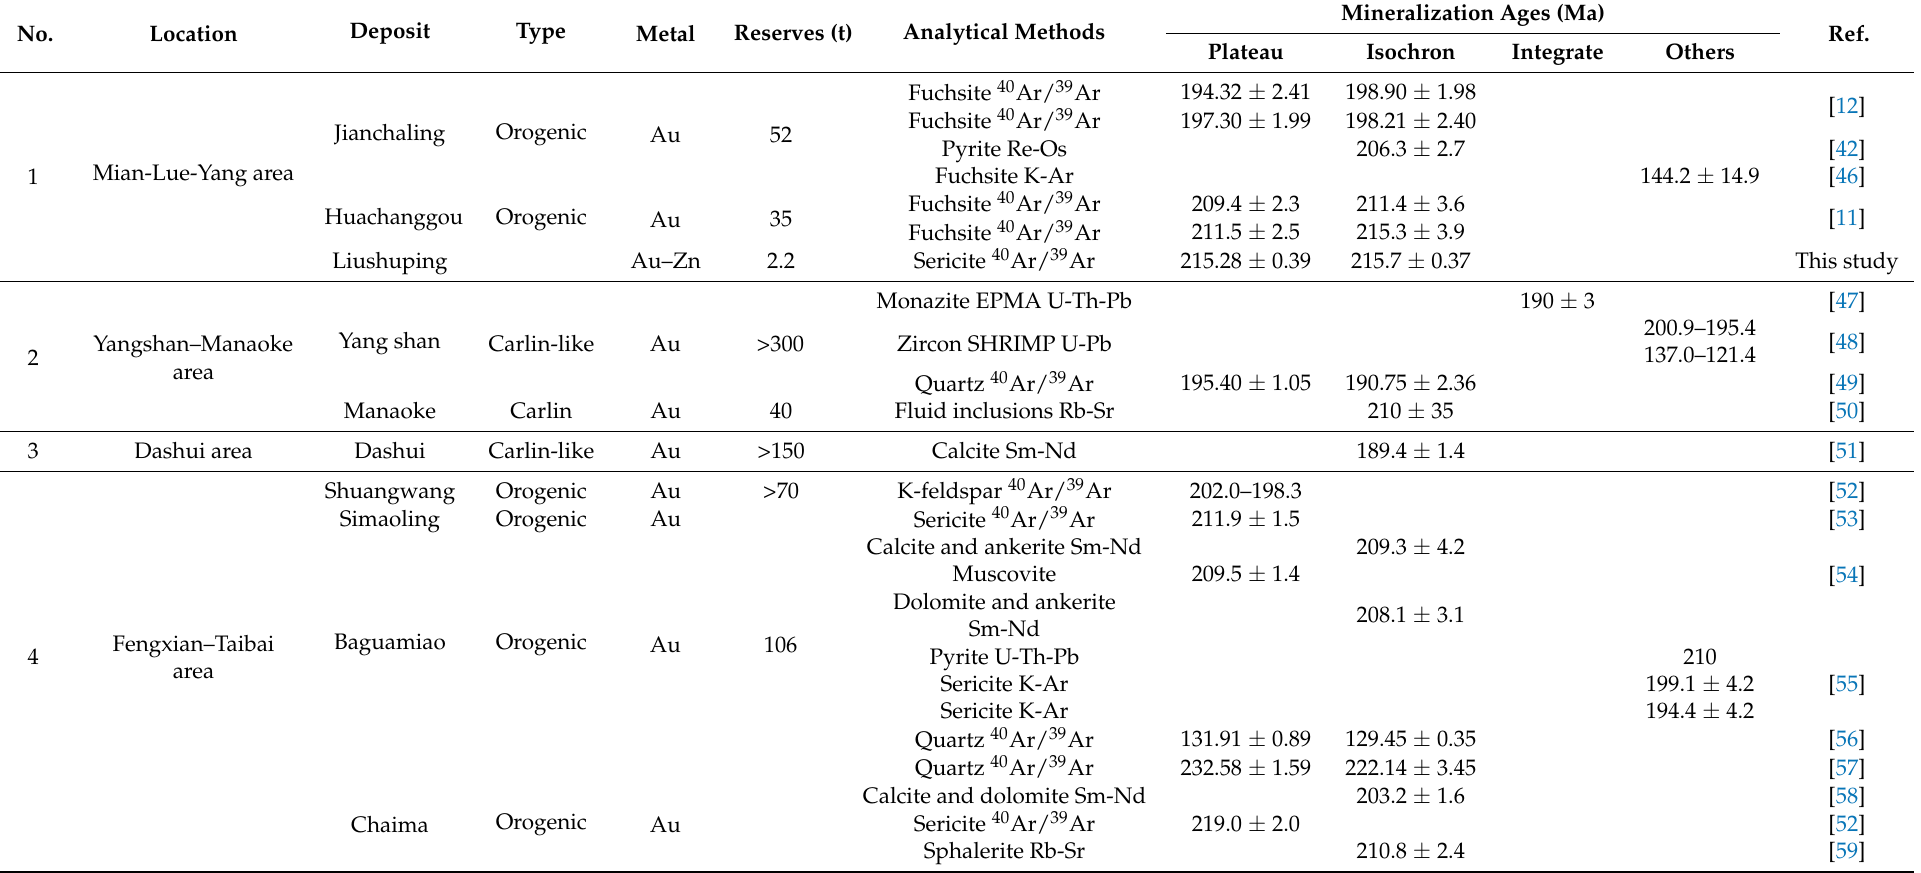
Table 3. Available age of gold deposits from West Qinling Orogen